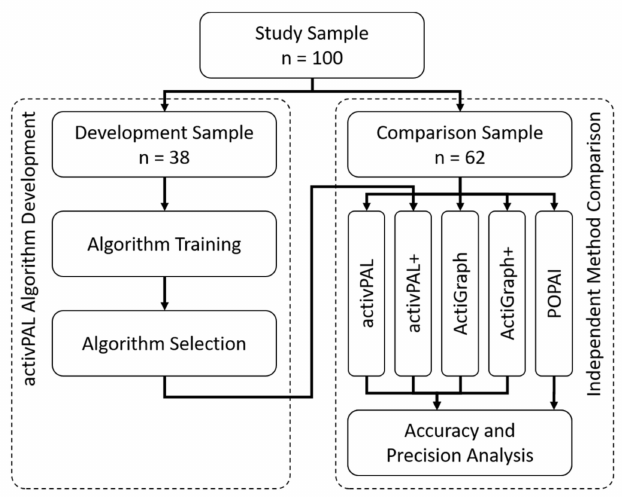
Figure 1. Flow-chart of the study with the development of the new activPAL energy expenditure algorithm for activPAL+ ( left ) and the subsequent independent method comparison with accuracy and precision ( right